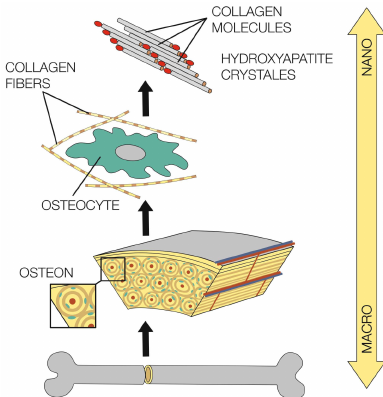
Figure 1. Different length scales in hierarchically organized bone. The macrostructure creates the overall bone shape and consists of trabecular (cancellous, spongy) bone, 50–90 vol % porosity and compact (cortical) bone, less than 10 vol % porosity [20]. The microstructure (of about 10–500 µ m) consists of the Haversian system, osteons and single trabeculae). The sub-microstructure (of 1–10 µ m) consists of lamellae. The nanostructure (a few hundred nanometers—1 µ m) consists of fibrillary collagen and embedded minerals. The sub-nanostructure (below a few hundred nanometers of minerals) consists of collagen, non-collagenous organic proteins, and fundamental structural